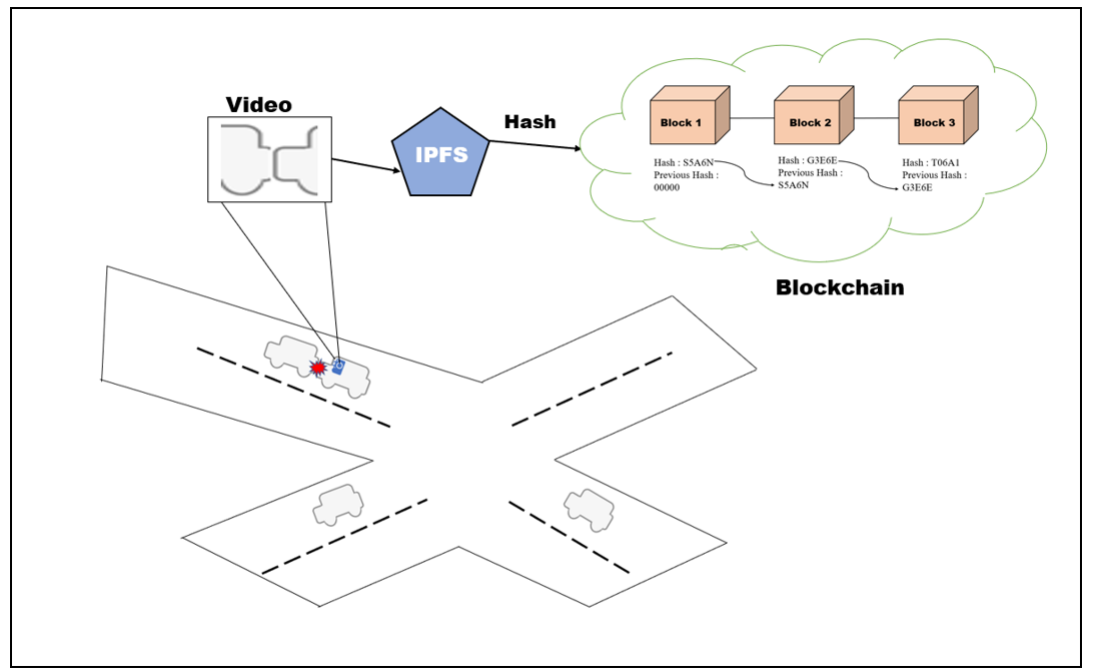
Figure 1. Example scenario to illustrate the application of the proposed system in the presence of accidents on the